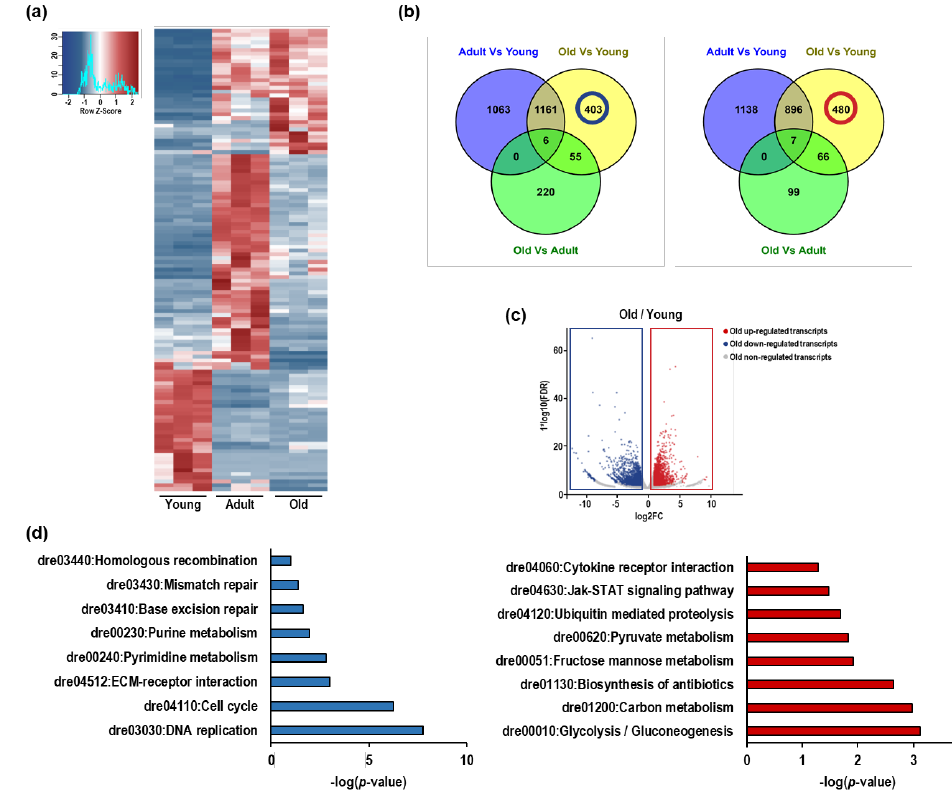
Figure 3. The expression of DNA repair and cell cycle genes decline in Nfu skeletal muscle with age, as expression of inflammation and glycolysis genes increase. ( a ) Heatmap showing the 50 most significant differentially regulated genes in young, adult, and old Nfu skeletal muscle identified by